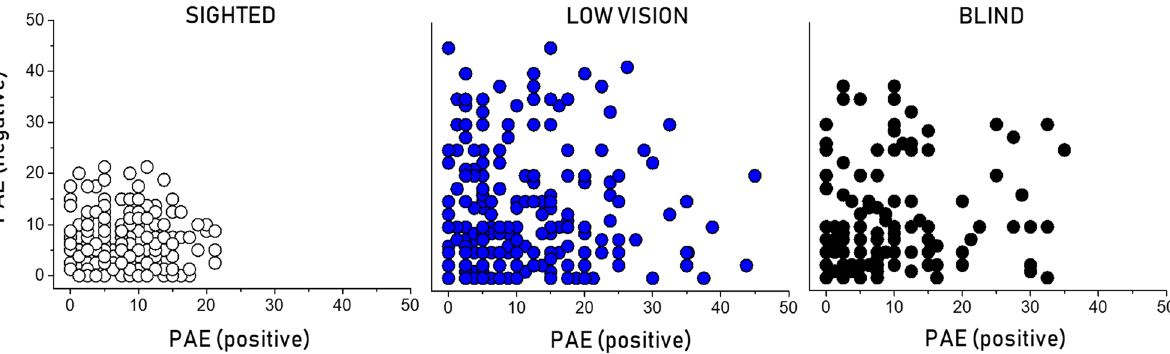
Figure 4. Detrimental effect of visual impairment on negative numbers representation. Individual data of blindfolded sighted (white), low vision (blue) and blind (black) children is graphically represented as Percentage of Absolute Error (PAE) for the positive (x-axis) and negative (y-axis) conditions of the task. Within each plot, the more the distribution shifts to the right the higher the error when representing positive numbers, while the more the distribution shifts to the top the higher the error when representing negative numbers. As can be seen, low vision’s performance is particularly shifted to the top and right, indicating lower performance for both positive and negative numbers